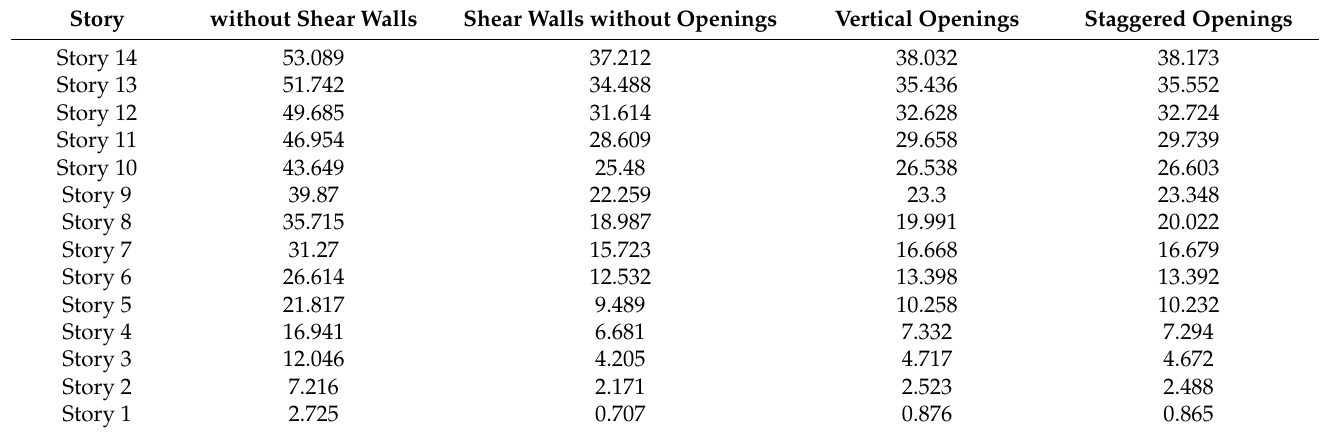
Table 4. Comparison of the story displacements, ESA and X-direction (mm).